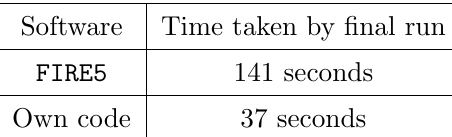
Table 1 . Time required to obtain the results eq. (5.9) with full dependence on the 8 master integrals including daughter topologies. The computation is performed on 1 CPU core on a laptop computer with an Intel Core i5 processor (clock frequency 2.5 GHz). Finite (cid:12)eld techniques and rational function reconstruction are not used for the timing comparison here, but will be used for the more complicated nonplanar (cid:12)ve-point